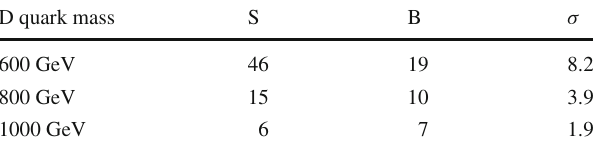
Table 4 Signal and background yields and significance for different D quark masses at HL-LHC